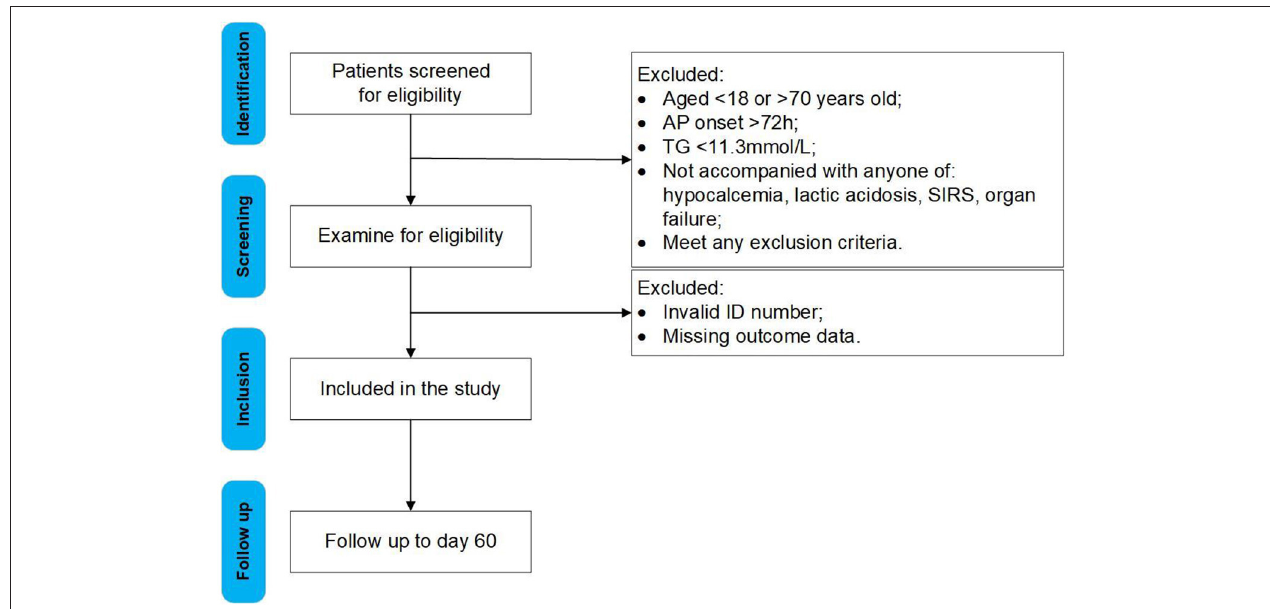
FIGURE 1 | Flow chart of